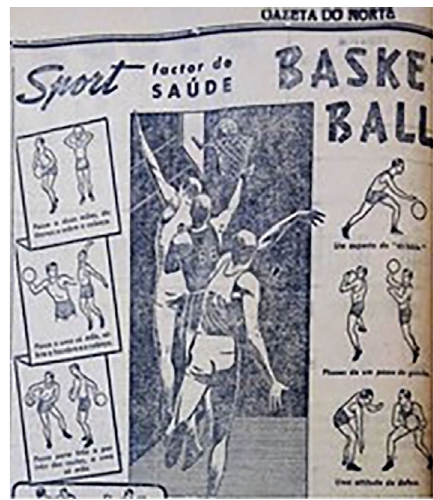
Figure 2 - Gillette advertisement featuring basketball. Source: Gazeta do Norte (Minas Gerais). Saturday, 8 October 1941, p. 3.